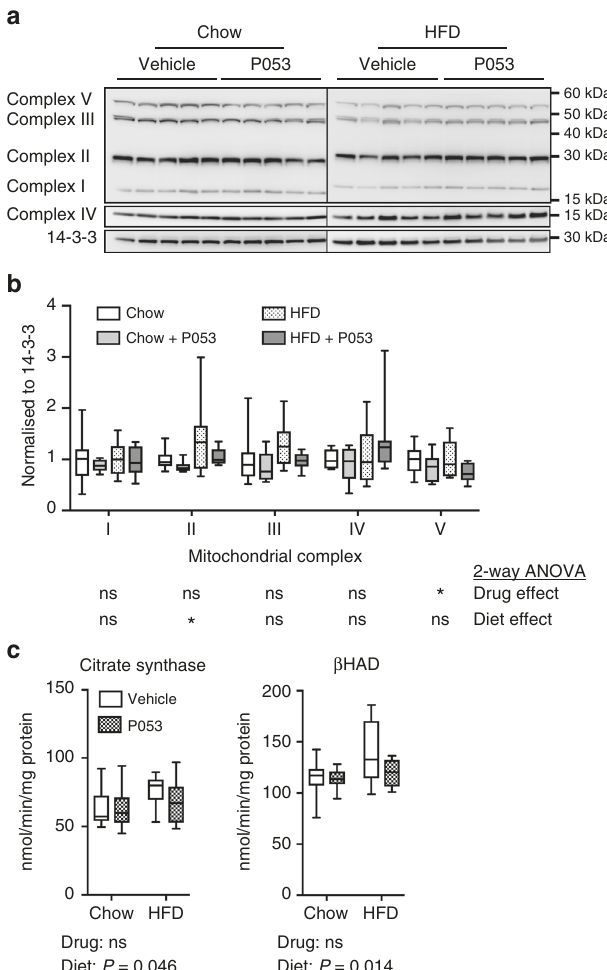
Fig. 7 CerS1 inhibition does not affect mitochondrial markers in liver. a Western blots of respiratory complex subunits, b densitometry for respiratory complex subunits relative to 14-3-3 protein, and c Citrate synthase and β HAD activity in liver homogenates; n = 10 mice for all groups. Box and whisker plots show full data range with 25th – 75th percentile boxed, and horizontal bar marking the median. Statistical signi fi cance was determined by two-way ANOVA, with the main effect of the drug or diet shown beneath each result; * P